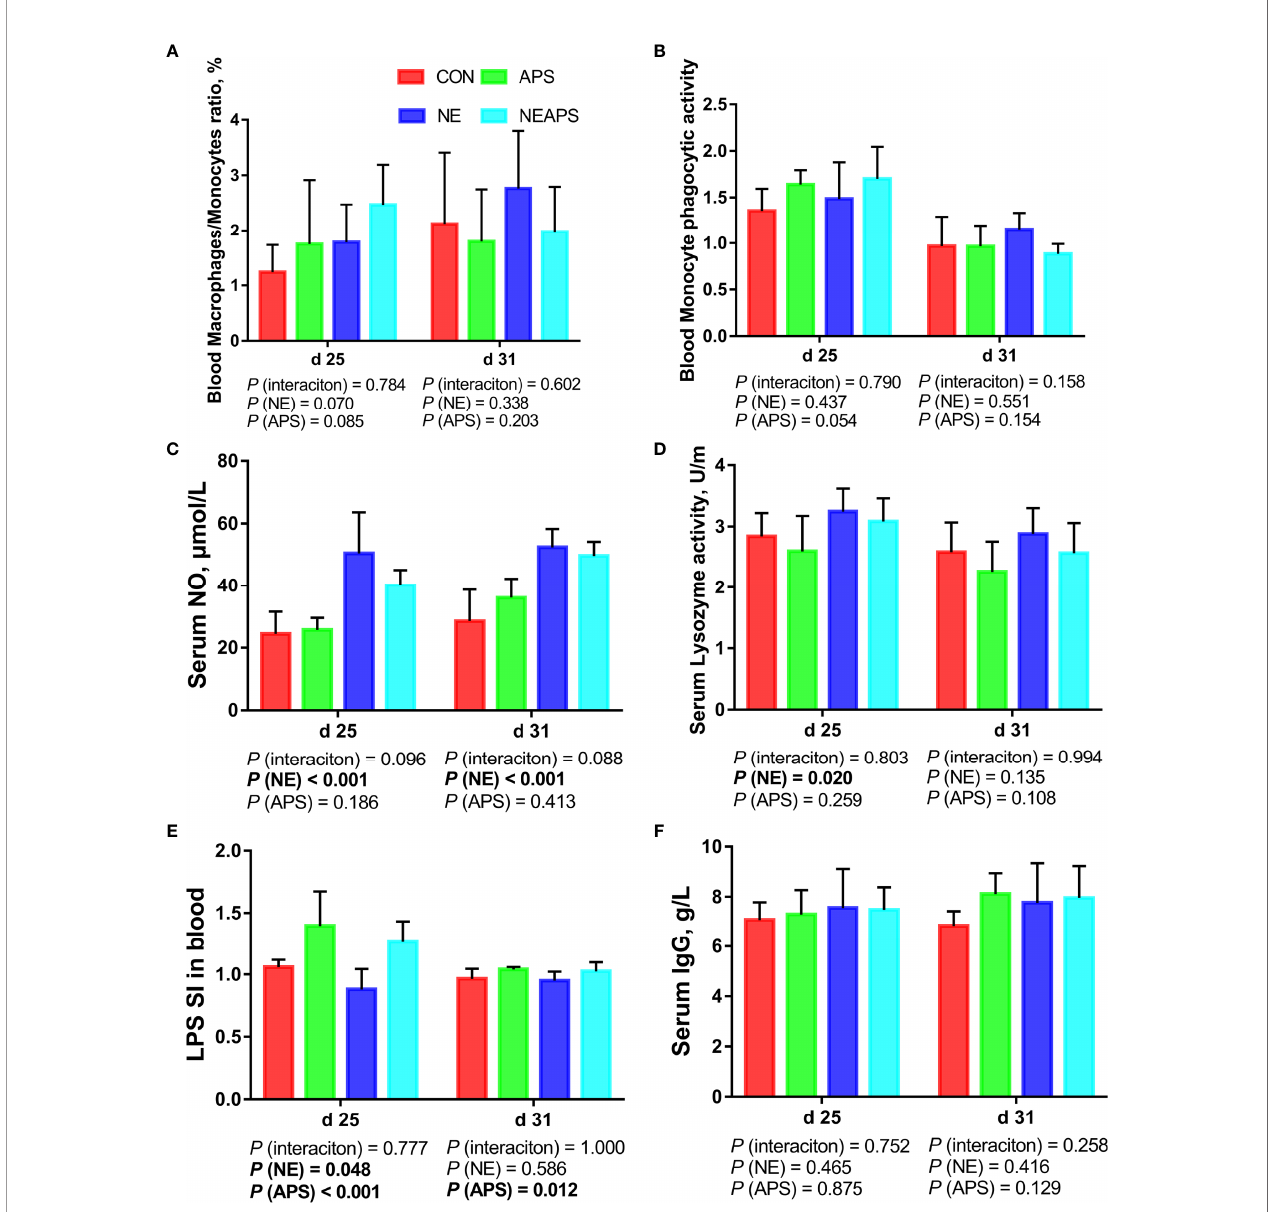
FIGURE 2 | Effects of dietary astragalus polysaccharides supplementation on peripheral nonspeci fi c immune function and humoral immune function of broiler chickens challenged with necrotic enteritis. The frequencies of Mononuclear/Macrophage (A) of peripheral blood lymphocytes were analyzed by fl ow cytometry. The phagocytic activity of Monocytes (B) was analyzed by neutral red method. The levels of NO (C) , lysozyme activity (D) , and IgG (F) were analyzed by ELISA kit. Peripheral blood lymphocytes were stimulated with lipopolysaccharide (LPS) (E) , and the stimulation index (SI) was calculated as described in the Materials and Methods section. All graphs are presented as mean, with the standard deviation (SD) shown via the whiskers. The main effect and interaction effects were analyzed using the general linear model (GLM) procedure, with the P values for the main effects written out below each plot. The one-way ANOVA and multiple comparisons were performed when interactive effects differed signi fi cantly. CON, control group; APS, APS group; NE, NE infection group; NEAPS, APS infected with NE